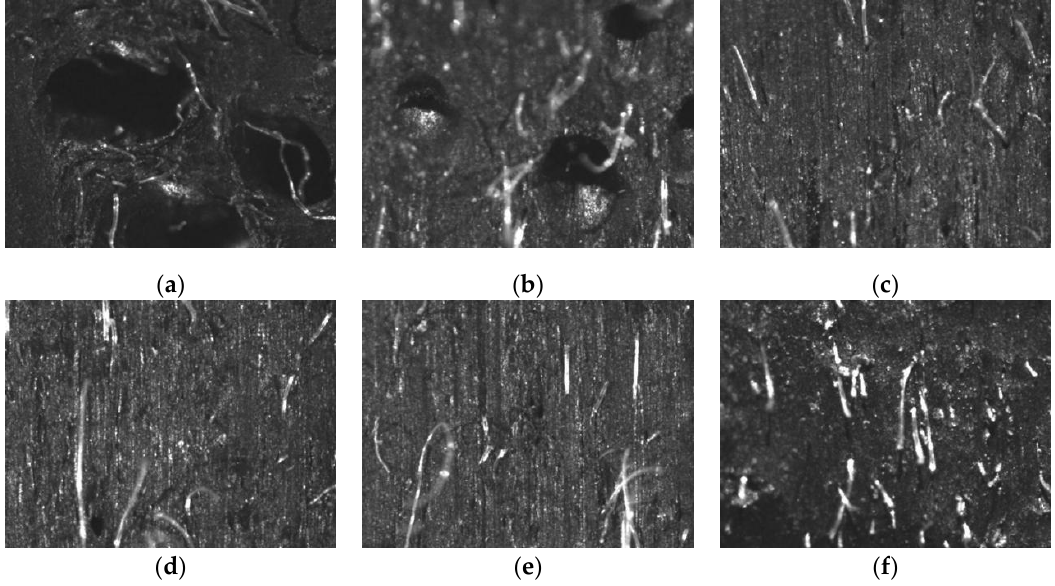
Figure 8. The compactness of rubber compound: ( a ) Y-1; ( b ) Y-2; ( c ) Y-3; ( d ) Z-1; ( e ) Z-2; ( f ) Z-3.